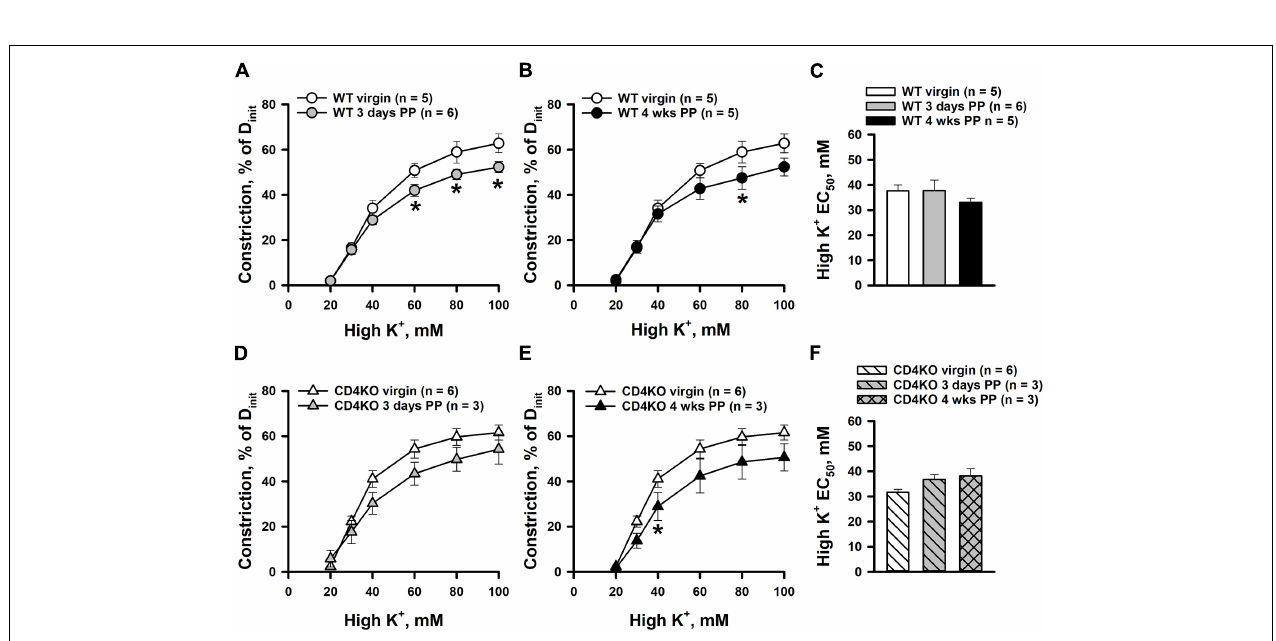
FIGURE 2 | High potassium (high K + )-induced constrictor responses of internal carotid arteries (ICAs) from C57BL/6 wild-type (WT) and CD4 T cell deficient (CD4KO) virgin and postpartum (PP) mice (A,B) Summary graphs showing a reduction in high K + -induced constriction of arteries from 3 days and 4 weeks PP WT mice compared to virgin controls (* P < 0.05, two way ANOVA). (C) Unaltered EC 50 values for high K + -induced constriction in arteries from WT PP and virgin mice ( P > 0.05, one way ANOVA). (D,E ) Constrictor responses to high K + solutions were unchanged in ICAs from 3 days and 4 weeks PP CD4KO mice compared to virgin controls ( P > 0.05, two-way RM ANOVA). (F) EC 50 values for high K + evoked constriction were not different in arteries from virgin vs. PP CD4KO mice ( P > 0.05, one way